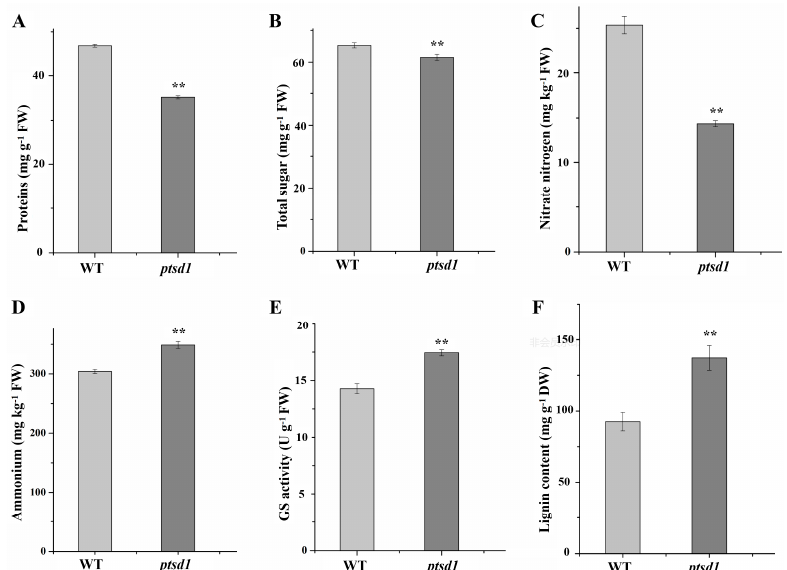
Figure 6. Physiological traits of WT and ptsd1 . The contents of proteins ( A ), total sugar ( B ), nitrate nitrogen ( C ), ammonium nitrogen ( D ), GS activity ( E ) and lignin ( F ) in spikes of WT and ptsd1 . Each sample has three independent biological replicates. Bars indicate the standard deviation. FW, fresh weight; DW, dry weight. The asterisks represent the significant difference between WT and ptsd1 (**: p ≤ 0.01).